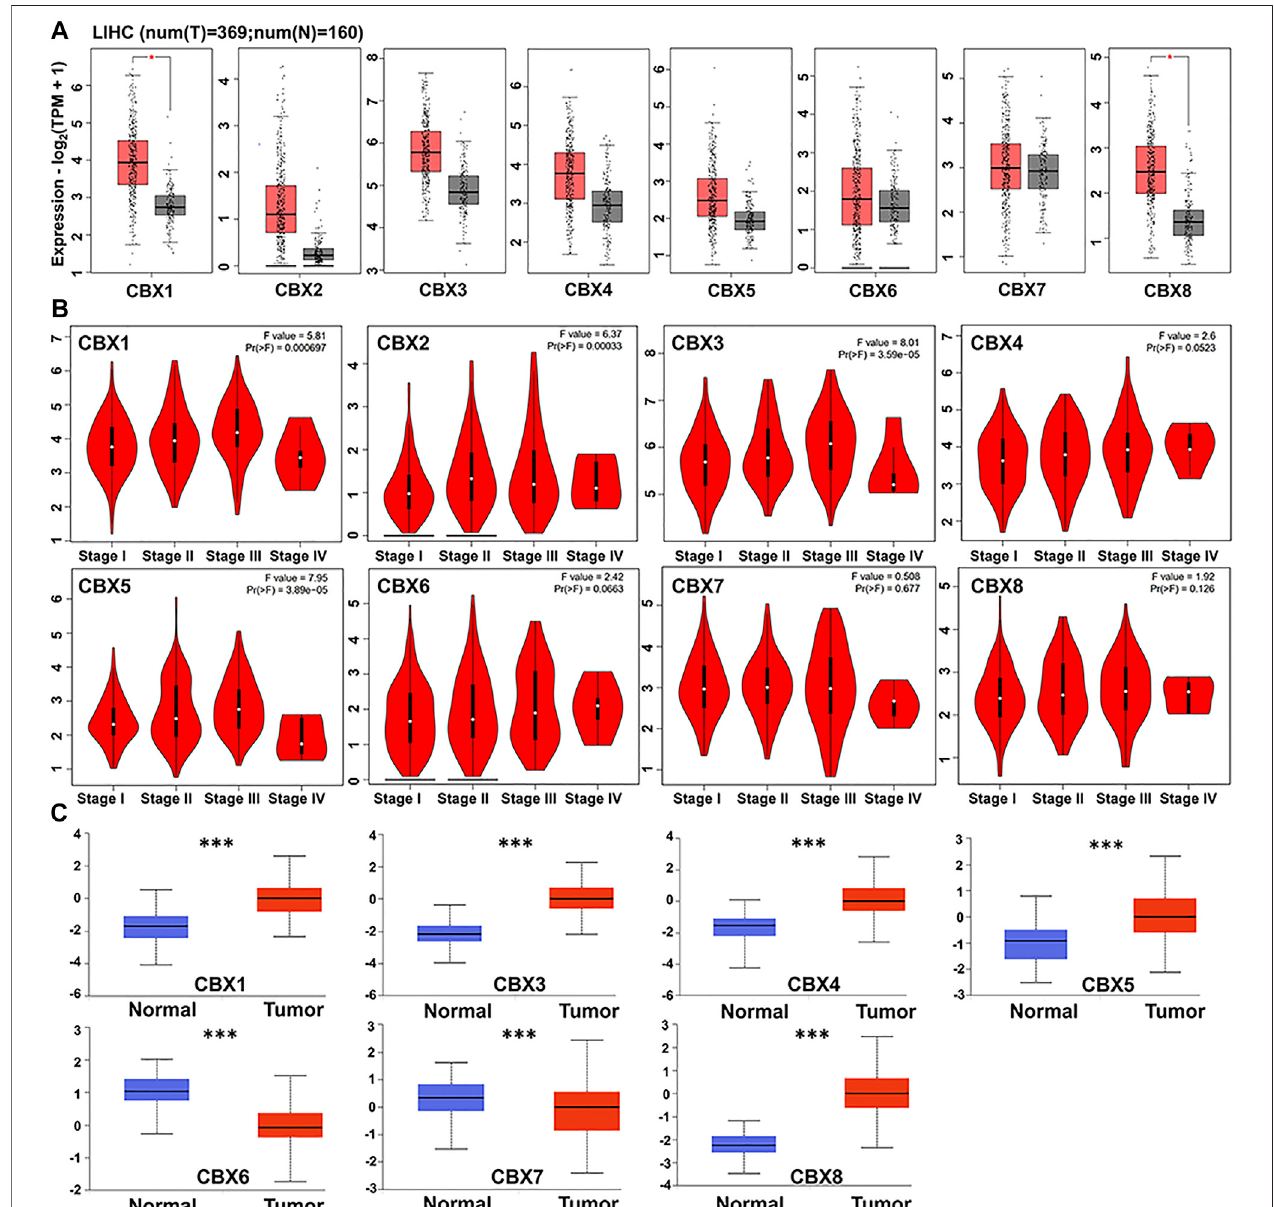
FIGURE 1 | (A) CBXs are expressed in HCC (GEPIA). The scatter diagram indicated that CBX1 and CBX8 expression levels were signi fi cantly greater in HCC tissues than in normal tissues ( p < 0.05) (B) Correlations between CBX expression and tumor stage in patients with head and neck cancer (GEPIA). CBX1/2/3/5 expression was shown to be signi fi cantly linked with the clinical stage of HCC patients ( p < 0.05). (C) Using the CPTAC dataset, we further compared the expression of CBXs total protein in normal and primary HCC tissue. *** p <